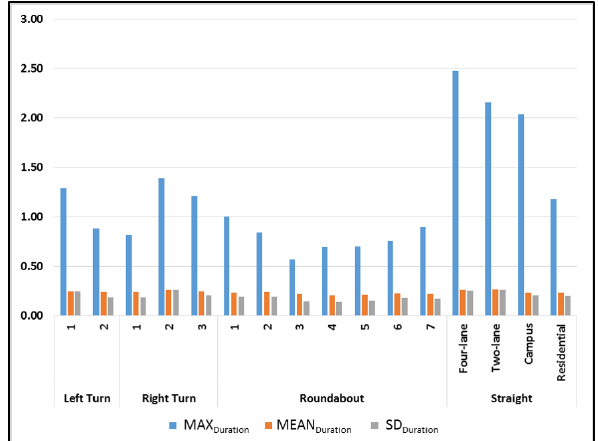
Figure 8. The statistics of the maximum, mean and standard deviation of eye fixations durations at different driving manoeuvres and sections.